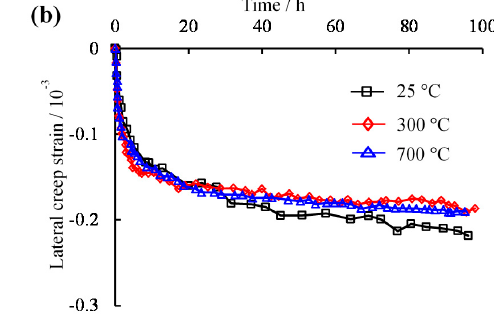
Figure 6. Lateral creep strain ‐ time curves under same stress condition at different temperatures ( σ 3 = 25 MPa): ( a ) σ 1 − σ 3 = 160 MPa; ( b ) σ 1 − σ 3 = 190 MPa; ( c ) σ 1 − σ 3 = 220 MPa; ( d ) Relationship between lateral creep and temperature.